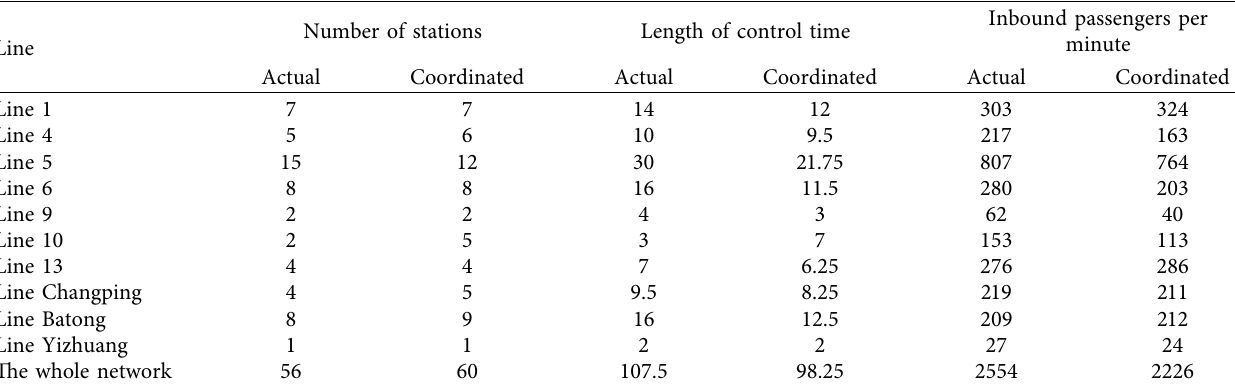
Table 5: Comparison of results between actual and coordinated control strategies.